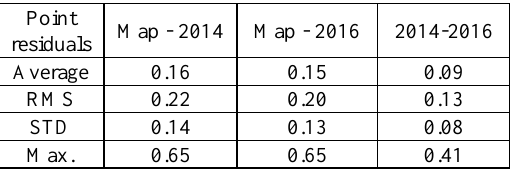
Table 7. Comparison of results of distances measurement measured in different datasets.